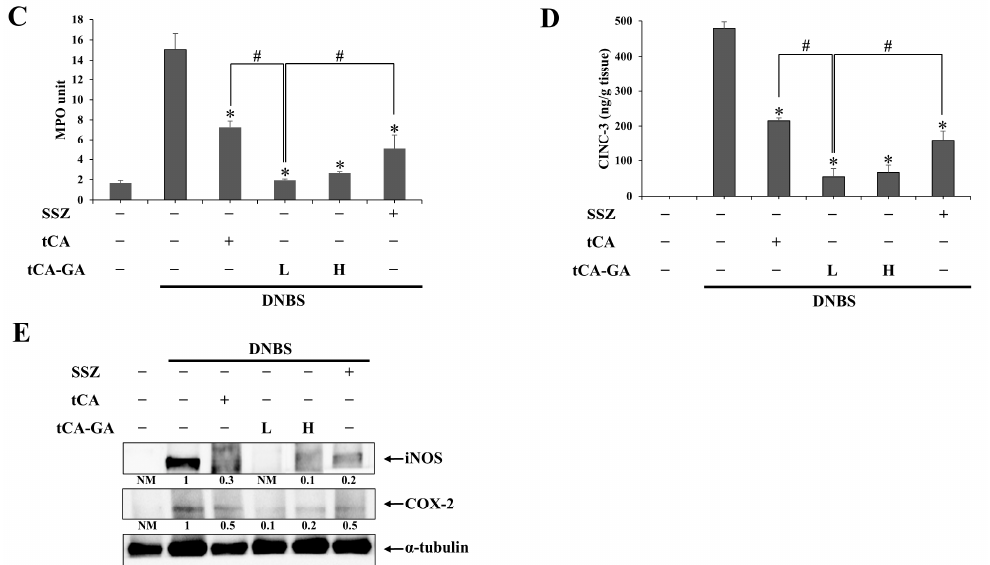
Figure 3. tCA-GA potentiates the anti-colitic activity of tCA and is more effective than SSZ at ameliorating rat colitis. DNBS-mediated colitis was induced for 3 days, and tCA (30 mg/kg), SSZ (30 mg/kg) or tCA-GA [equivalent to 15 mg/kg (L), as well as 30 mg/kg (H) of tCA] suspended in PBS (1.0 mL) was administered orally to colitic rats once per day. One day after the last treatment, the rats were killed to evaluate anti-colitic effects of the drugs. ( A ) Left panel: Photos of the distal colons of rats where serosal and luminal sides are shown separately. Right panel: Overall colonic damage was scored for each group and presented as colonic damage score (CDS). * α < 0.05, vs. DNBS control ( B ) H&E staining was performed with the colon sections of rats subjected to various treatments. Upper panel: Representative images of 100× magnification (scale bar: 200 µm). Lower panel: Representative images of 200× magnification for the dotted boxes in the upper panel (scale bar: 100 µm). In the inflamed distal colons (4.0 cm), ( C ) myeloperoxidase (MPO) activity was measured in addition to determining the levels of ( D ) CINC-3, ( E ) iNOS, and COX-2 using an Elisa kit and Western blotting. A loading control ( α -tubulin) was used for Western blot analysis of COX-2 and iNOS. The data in ( A , C , D ) are presented as mean ± SD (n = 5). Statistical significance was analyzed using a one-way ANOVA followed by Tukey’s HSD test, * p < 0.05, vs. DNBS control. # p < 0.05.